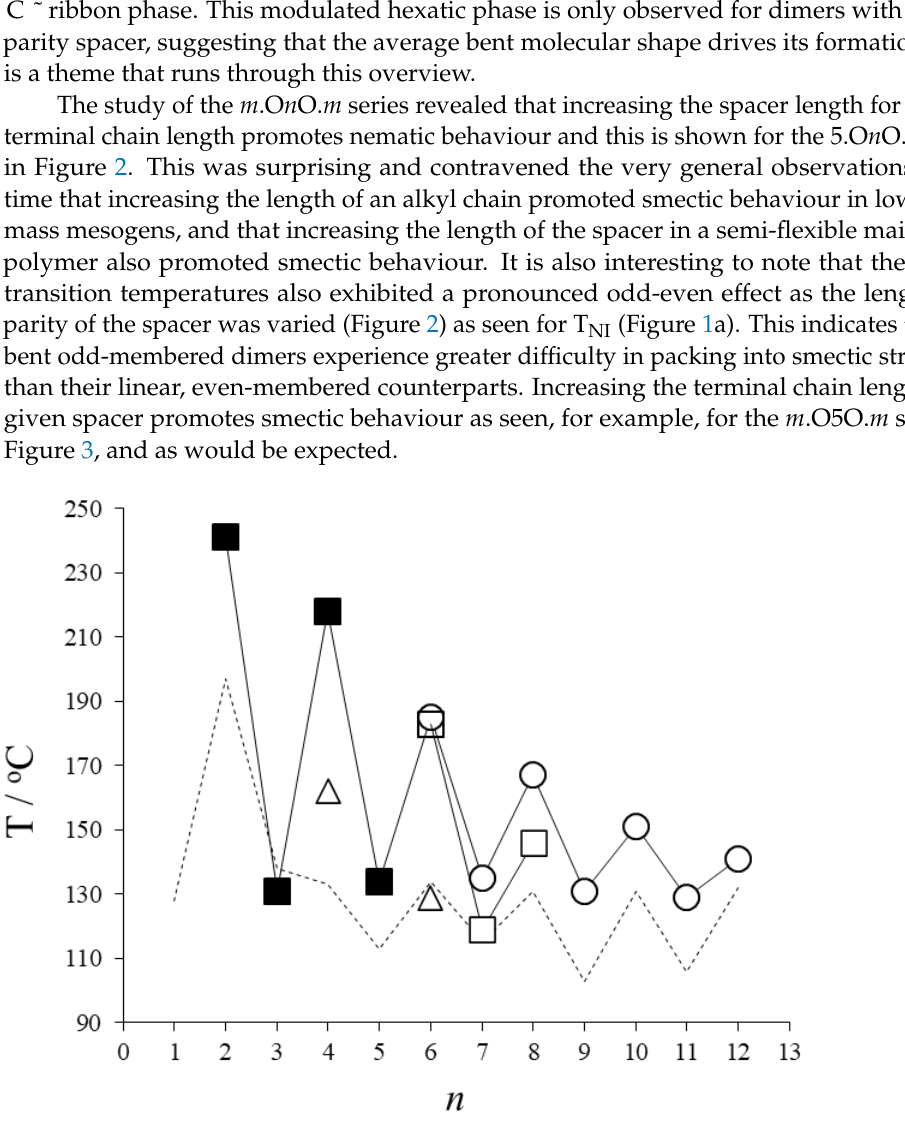
Figure 2. The dependence of the transition temperatures on the number of methylene groups, n , in the flexible spacer for the 5.O n O.5 series [10]. The broken line joins the melting points. Filled squares denote T SmAI ; unfilled squares T SmAN ; circles T NI ; triangles T SmASmB .